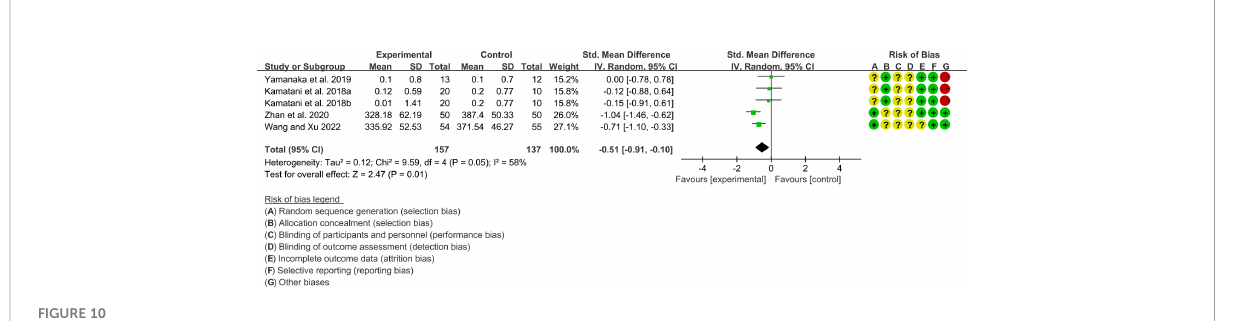
FIGURE 10 Serum Uric acid (CI, con fi dence interval; SD, standard deviation).